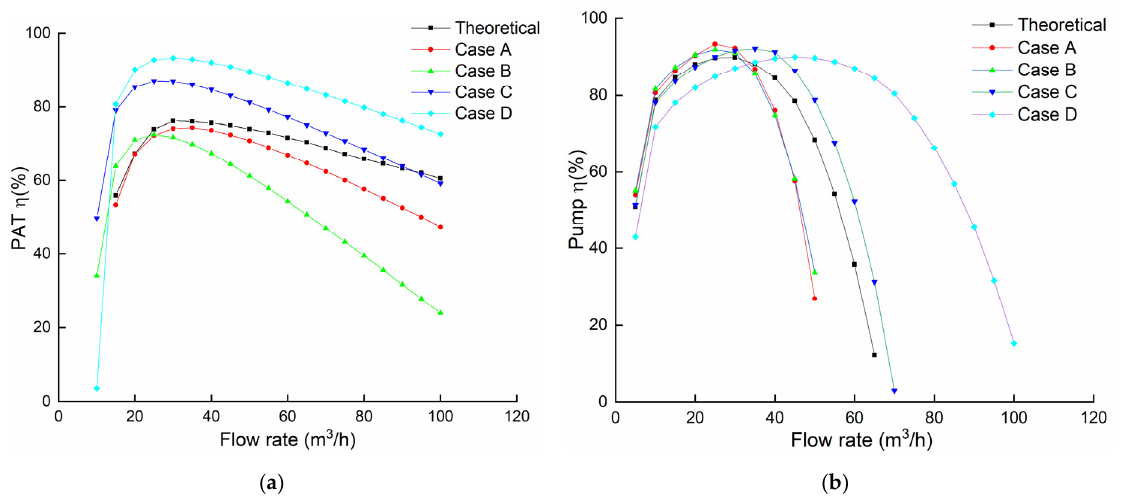
Figure 19. Optimized efficiencies of ( a ) PAT and ( b ) pump respectively.